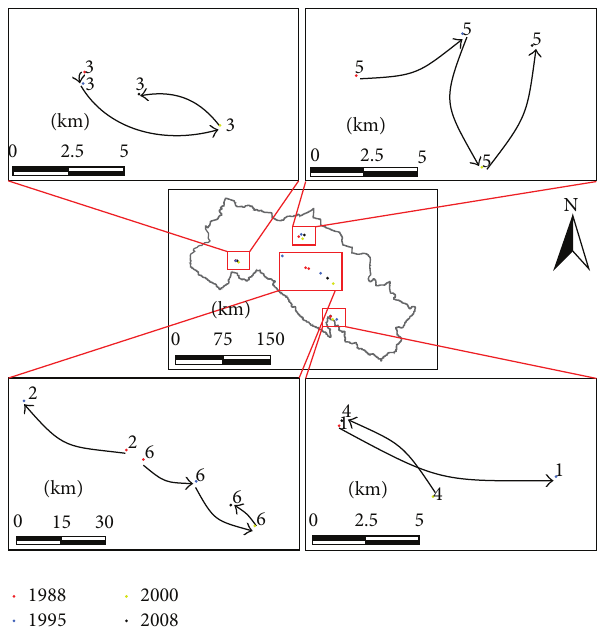
Figure 7: Spatial shifts of the center of gravity of ecosystem service zones. Note: 1: supporting function, 2: nutrient cycling supporting function, 3: soil supporting function, 4: fuelwood provision func- tion, 5: climate regulating function, and 6: food provision function. ecosystem service and raise the provision and regulating